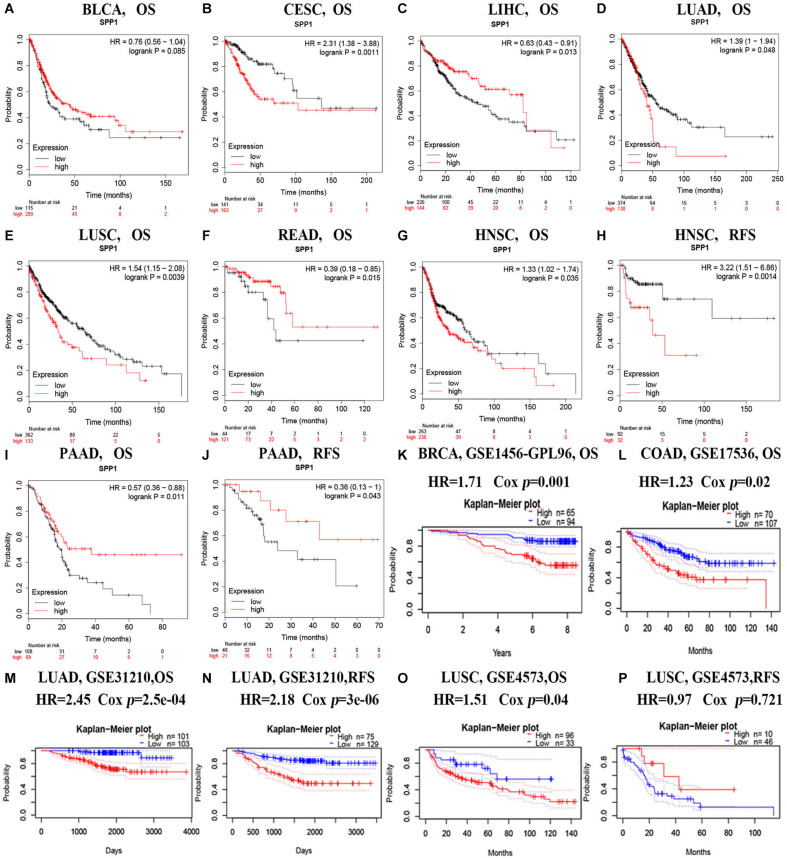
Survival for diverse cancer types according to SPP1 level based on the Kaplan-Meier plotter (A–J) and PrognoScan databases (K–P). (A–J) The OS and RFS curves for BLCA (n = 404), CESC (n = 304), LIHC (n = 370), LUAD (n = 504), LUSC (n = 495), READ (n = 165), HNSC (n = 499 and n = 124) and PAAD cancer (n = 177 and n = 69). (K,L) Survival curves of OS in BRCA [GSE1456 (n = 159)] and COAD [GSE17536 (n = 177)]. (M,N) Survival curves of OS and RFS in LUAD [GSE31210 (n = 204) and GSE31210 (n = 204)]. (O,P) Survival curves of OS and DFS in LUSC [GSE4573, (n = 129) and GSE4573 (n = 56)]. RFS, relapse-free survival; OS, overall survival.